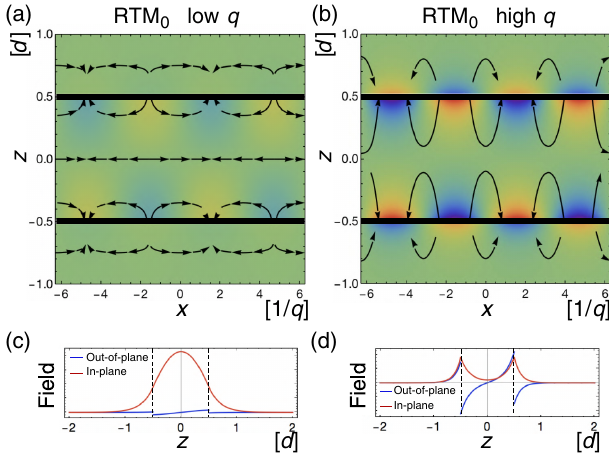
FIG. 11. (a),(b) Electrical flux lines and (c),(d) spatial profiles of the mode function (i.e., the electric field) for the most-softened phonon mode denoted as the RTM 0 mode. Without loss of generality, we consider the mode propagating in the x direction with the in-plane momentum q ¼ q and the vanishing electric x 0 . (a),(b) The black solid curved field in the y direction E y ¼ arrows indicate the electrical flux lines on the xz plane at (a) low and (b) high in-plane momenta q . The color indicates the magnitude of the electric field E perpendicular to the interfaces. z (c),(d) The spatial profiles of the in-plane (red solid curve) and the out-of-plane (blue solid curve) components of the electric field at x ¼ 0 in (a) and (b) are plotted in (c) and (d) in the arbitrary unit, respectively. The black dashed vertical lines indicate the inter- faces at j z j ¼ d= 2 . The parameters are d ¼ c= Ω , g ¼ 3 . 5 Ω , and ω 5 Ω . We set q ¼ 0 . 1 Ω =c in (a),(c) and q ¼ 7 Ω =c in p ¼